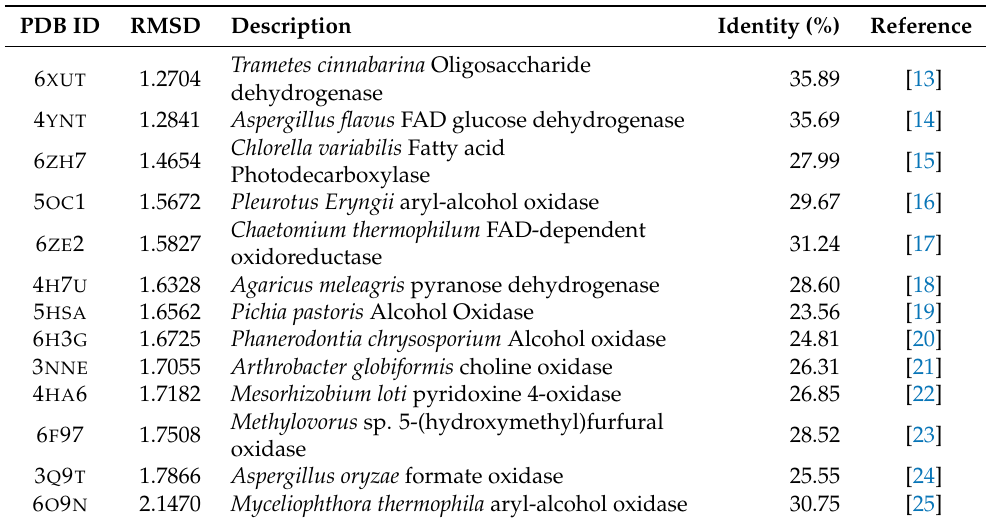
Table 2. Proteins from the PDB similar in structure to A. niger glucose oxidase. Structures were identified by a BLAST search against the PDB using the A. niger sequence. Listed structures covered at least 75% of the query sequence and represent unique structures. All these proteins are members of the GMC oxidoreductase